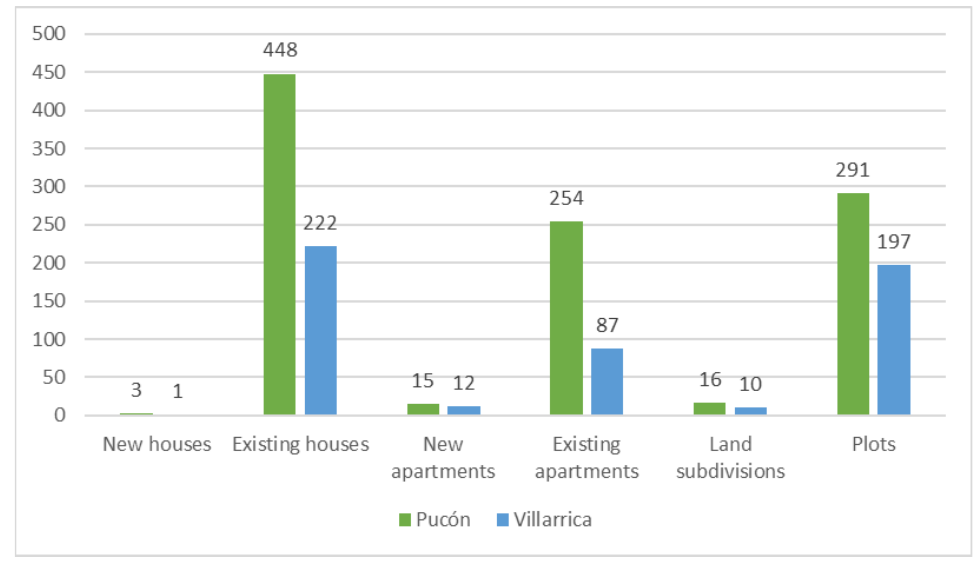
Figure 7. Square metres of housing built in the district of Pucón, 2017 – 2021. Source: compiled by the authors using data from Portal Inmobiliario.